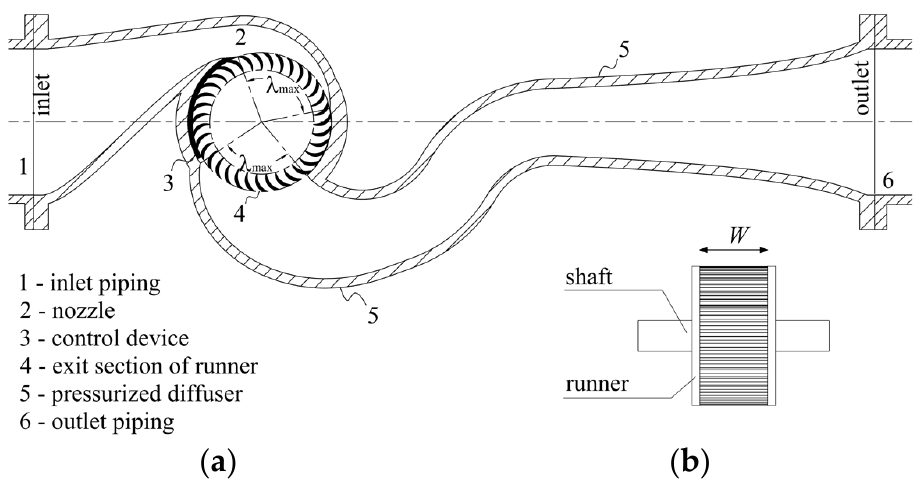
Figure 2. PRS turbine for medium head jumps: ( a ) Section view of the turbine in a symmetry plan; ( b ) Side view of the rotor [9,13].